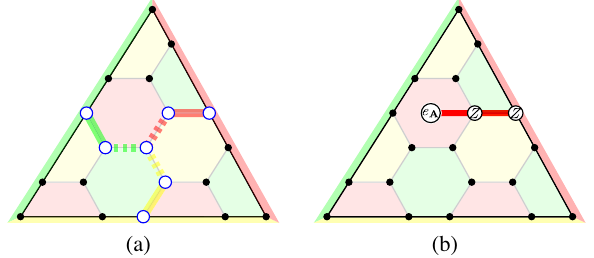
FIG. 15. (a) A logical string consists of three colored strings extending from their respective boundary and meeting at a point. The support of the logical X or Z is indicated by the larger white nodes. (b) e excitations appear at the ends of an A -colored Z A string. Both e and m excitations can condense on the A A A -colored boundary (and analogously for other